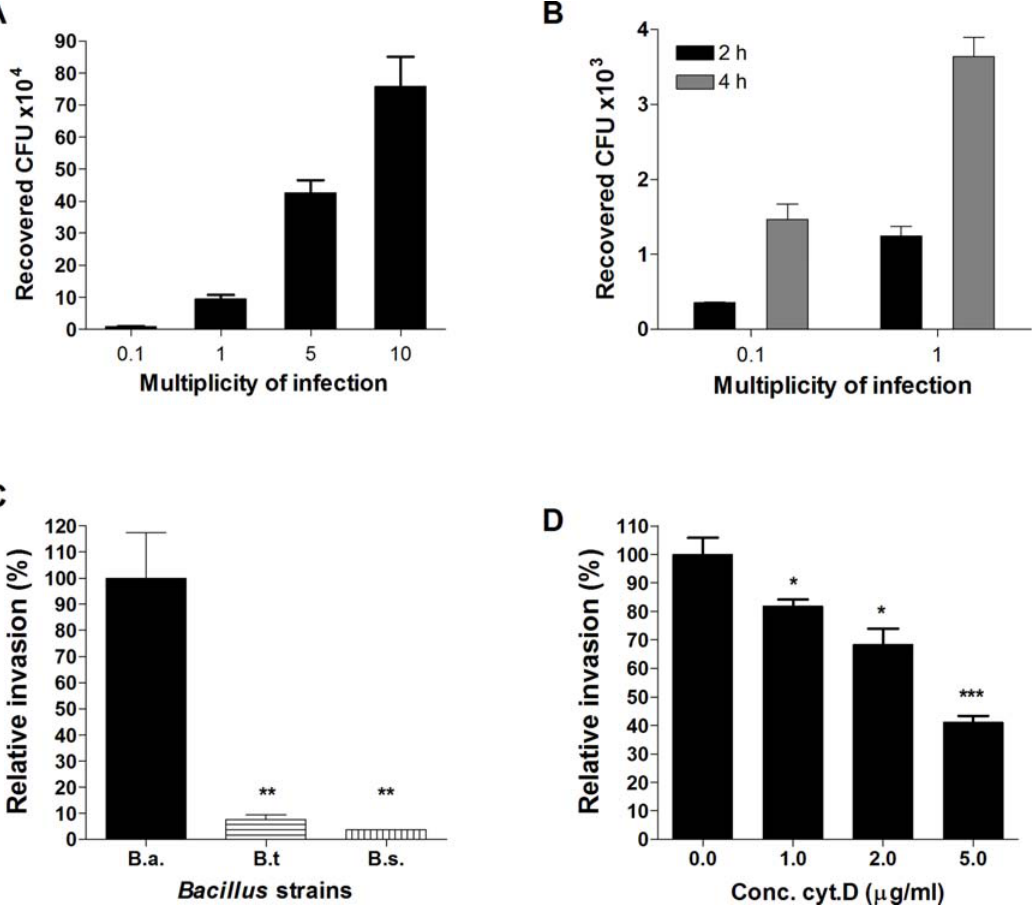
Figure 2. Interaction of B.anthracis Sterne with hBMEC. B. anthracis Sterne (A) adheres to and (B) invades hBMEC. Data are expressed as the recovered total cell-associated or intracellular colony forming units (CFU). MOI of 0.1, 1, 5, 10 is approximately 1 6 10 4 , 1 6 10 5 , 5 6 10 5 , and 1 6 10 6 CFU respectively (C) Invasion of hBMEC by B. anthracis Sterne (B.a.) and closely-related B. thuringensis (B.t.) and B. subtilis (B.s.). (D) Concentration- dependent inhibition of B. anthracis hBMEC invasion by cytochalasin D, a potent inhibitor of actin cytoskeleton rearrangements. All experiments were repeated at least three times in triplicate, data from a representative experiment are shown. The error bars indicate 95% confidence intervals of the mean of three